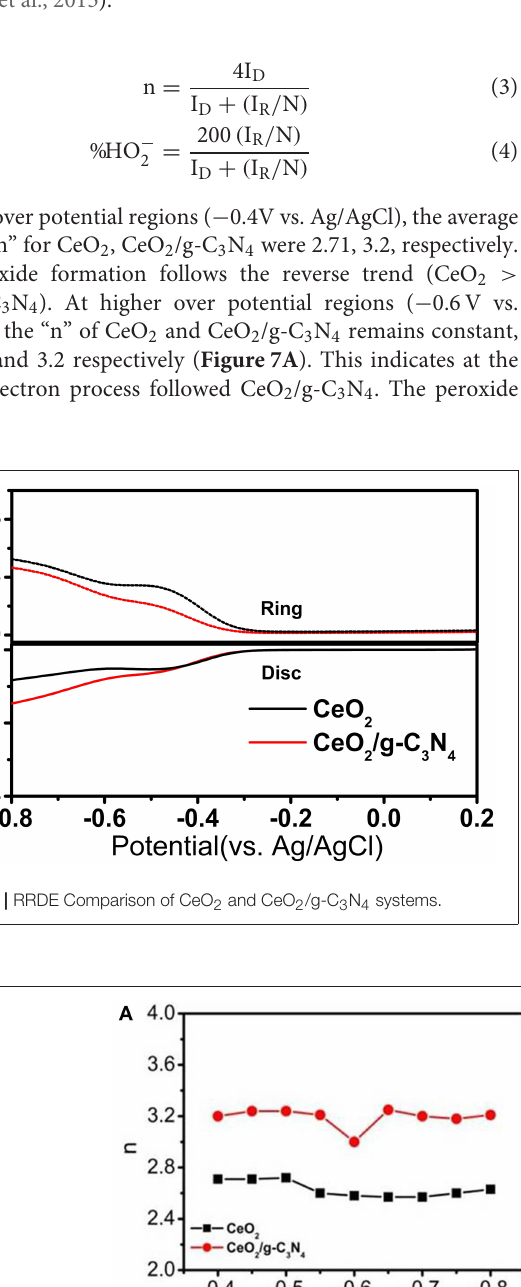
Frontiers in Chemistry |